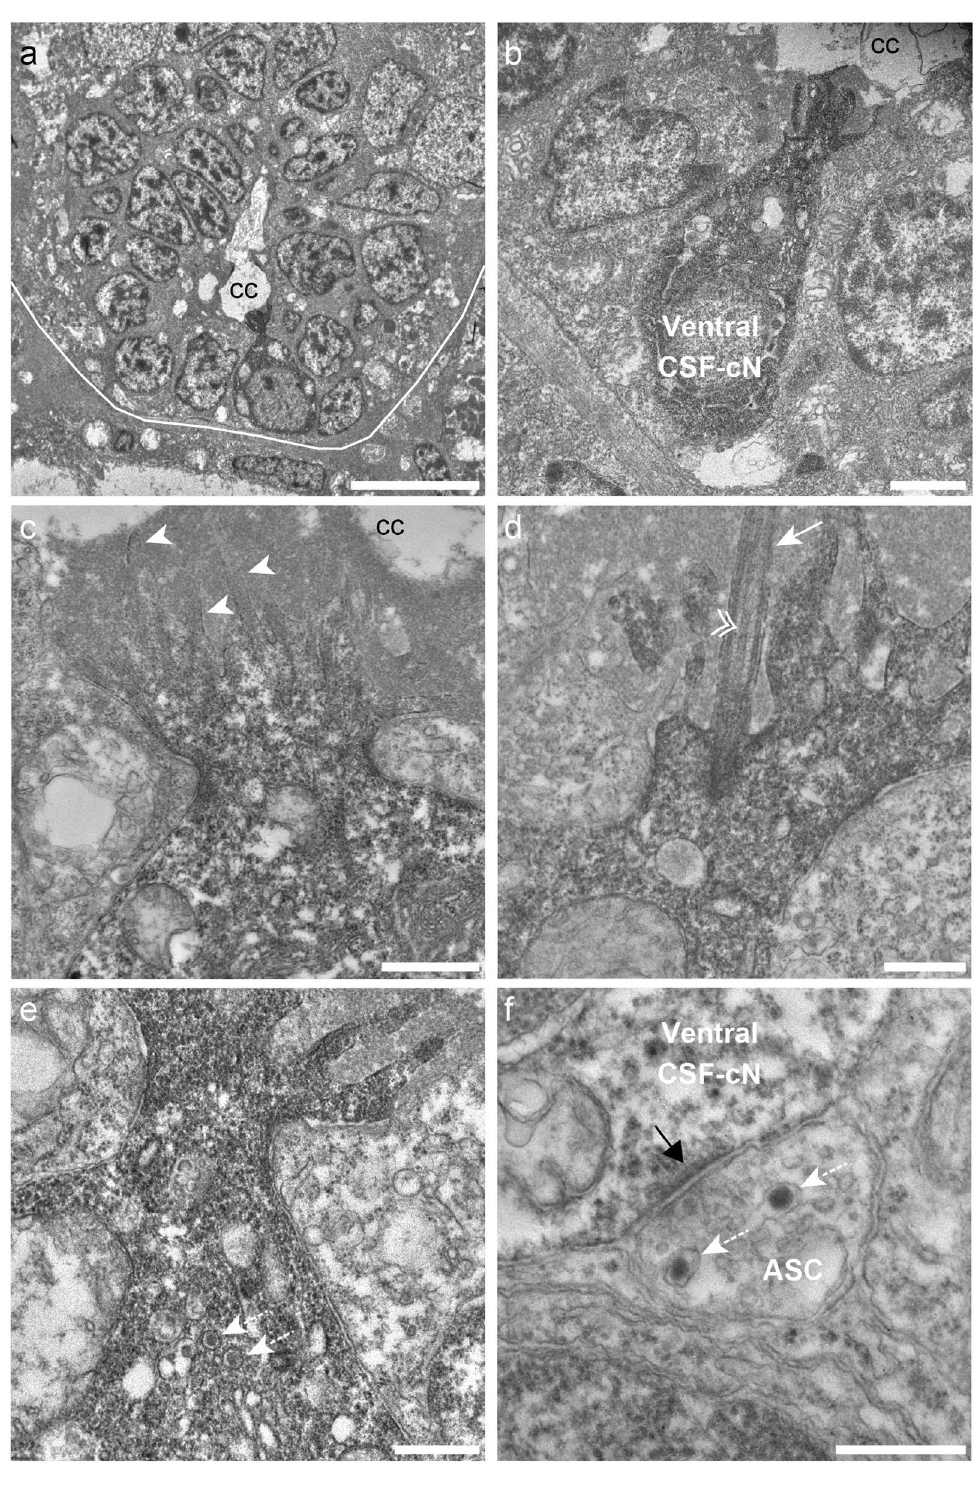
Figure 1. Ventral CSF-cNs exhibit an apical extension composed of microvilli and a kinocilium in the spinal cord. ( a ) Transverse section of the spinal cord showing restricted deposition of DAB in a ventral CSF-cN. ( b ) Overall view of a DAB + ventral CSF-cN contacting the central canal (cc) and surrounded by ependymal cells. ( c ) Ventral CSF-cNs project at the apical pole an extension toward the central canal bearing several microvilli (arrowheads). ( d ) Within this extension is located a cilium (arrows) with two central microtubule along the axoneme (double arrowhead), suggesting a motile cilium. Large granular vesicles (LGV) are observed in the cytoplasm ( e , dotted arrows) and axo-somatic synaptic contacts in the basal pole ( f , ASC). Note the symmetry of the synaptic contact (black arrow) is reminiscent of an inhibitory synapse. Note the presence of LGV in the axon ( f , dotted arrows). Scale bar = 10 μ m ( a ), 2 µ m ( b ), 1 μ m ( c ), 500 nm ( d , e ) and 400 nm ( f